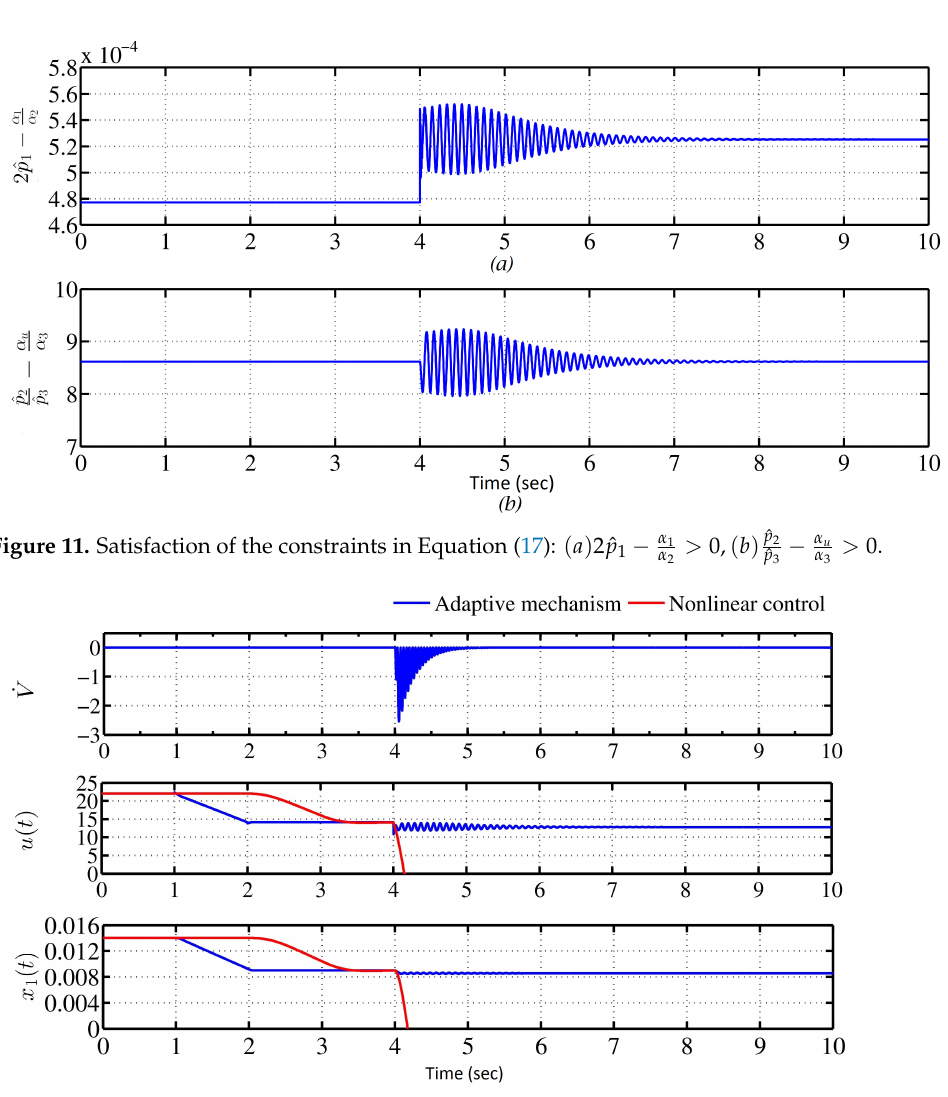
Figure 12. Response of ˙ V , control action u ( t ) , and ball position x 1 ( t ) with parametric